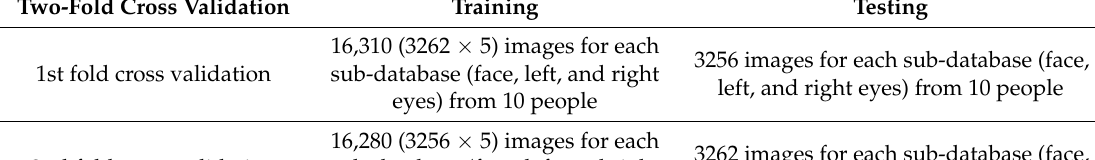
Table 4. Description of training and testing images from DDGC-DB1.